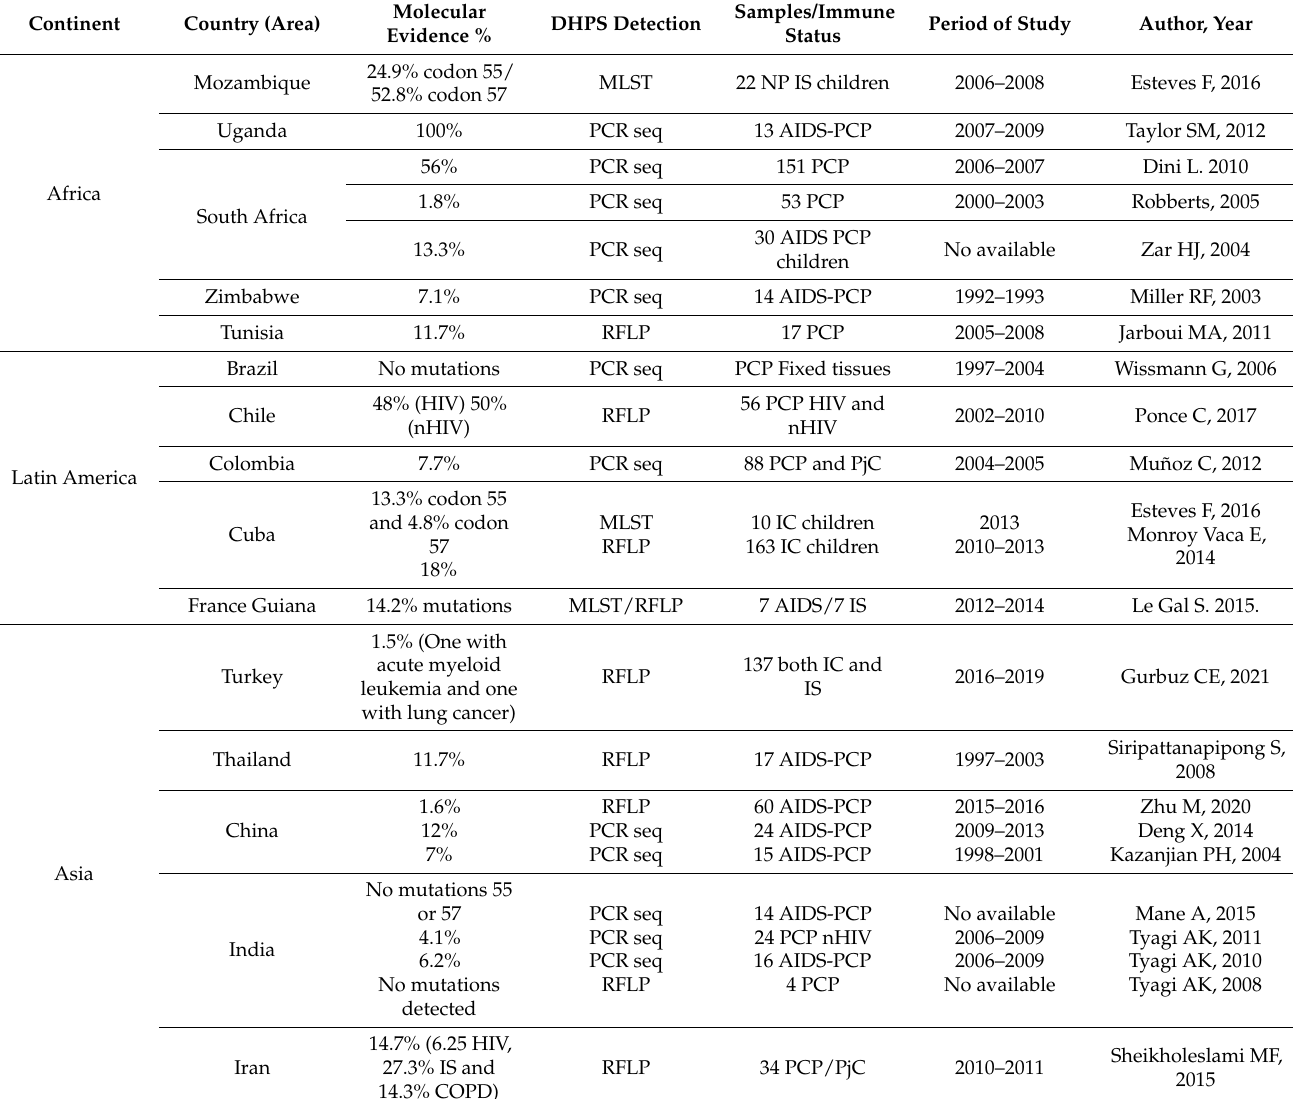
Table 3. Distribution of DHPS mutated strains in developing